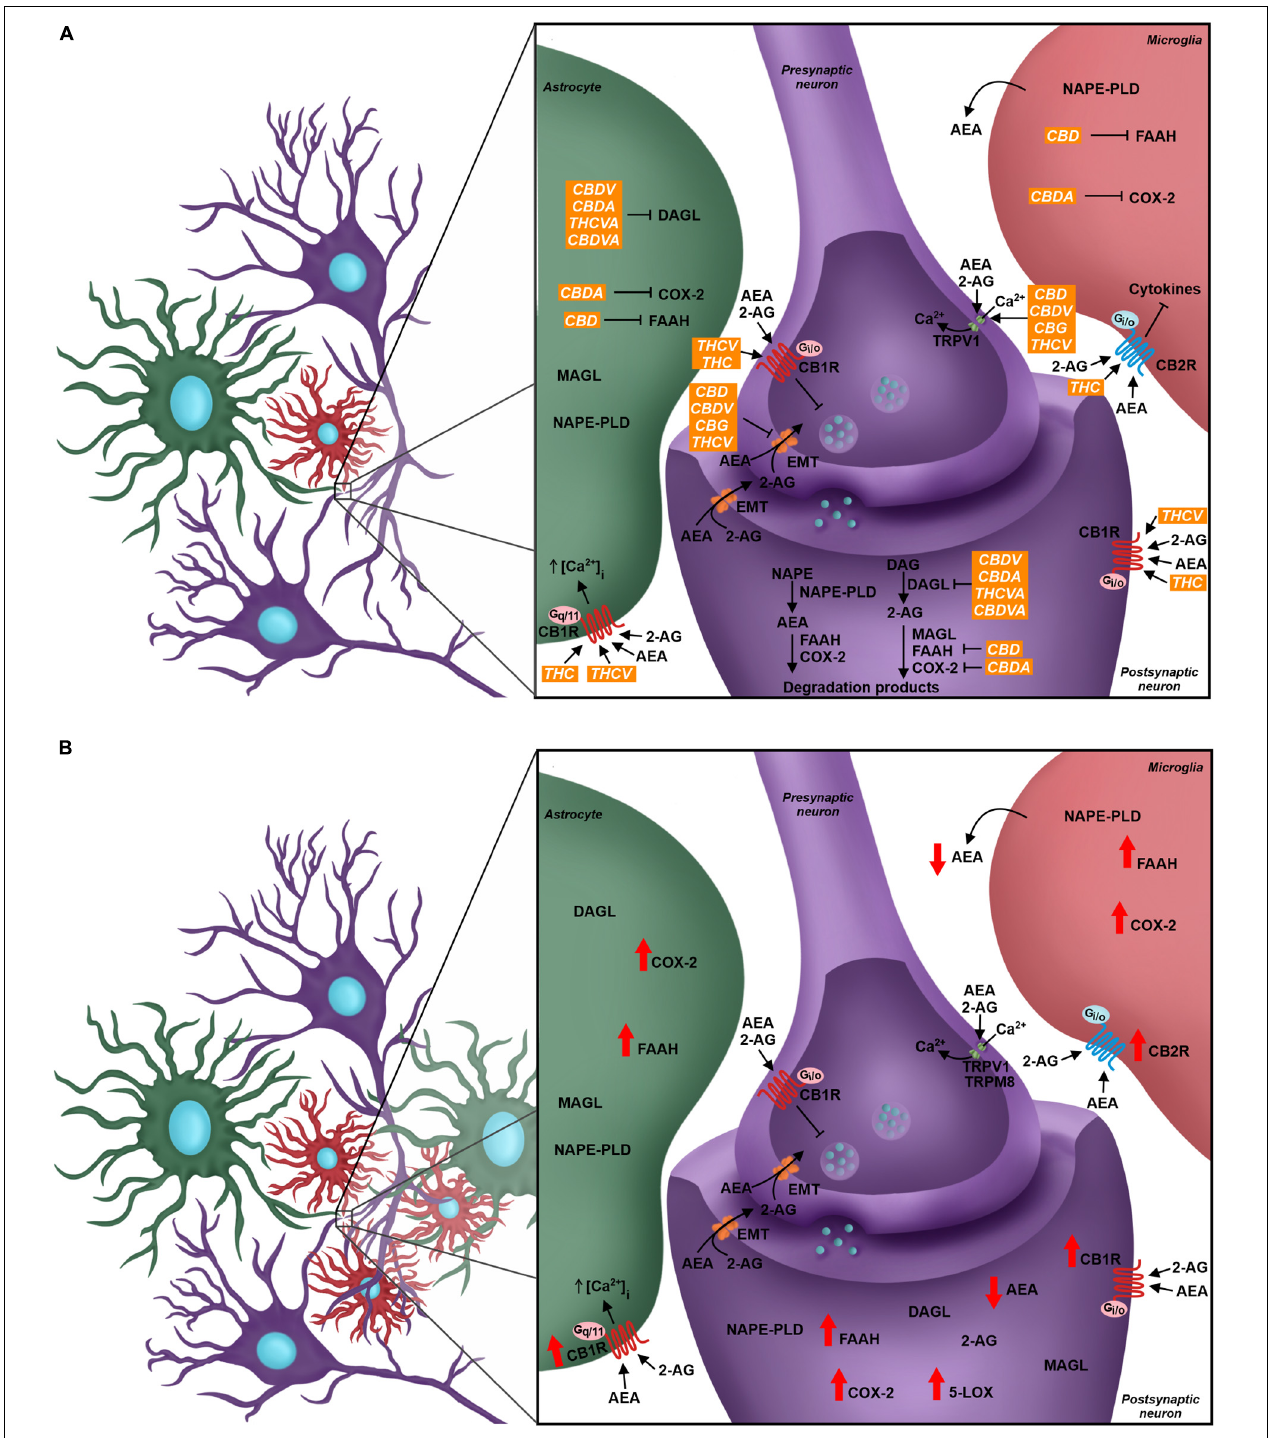
FIGURE 2 | The role of the endocannabinoid system (eCS) in the quadripartite synapse, its modulation by phytocannabinoids and alterations due to Neuropathic Pain. (A) Neurons, astrocytes, and microglial cells have the eCS components, and the endocannabinoid signaling through CB1R and CB2R leads to different outcomes in each cell. The presynaptic neuron expresses CB1R, TRPV1, TRPM8, and the endocannabinoid membrane transporter (EMT). Receptors are targeted by endocannabinoids (AEA and 2-AG). CB1R modulation activates signaling cascades that inhibit Ca 2 + intracellular influx, which decreases the fusion of intracellular vesicles with the neuron membrane, changing the neurotransmitter release flow. The postsynaptic neuron also presents, besides the receptors, all the elements of the ECS, such as the AEA and 2-AG synthesis enzymes, respectively NAPE-PLD and DAGL, and the degradation enzymes, FAAH, MAGL, and other enzymes